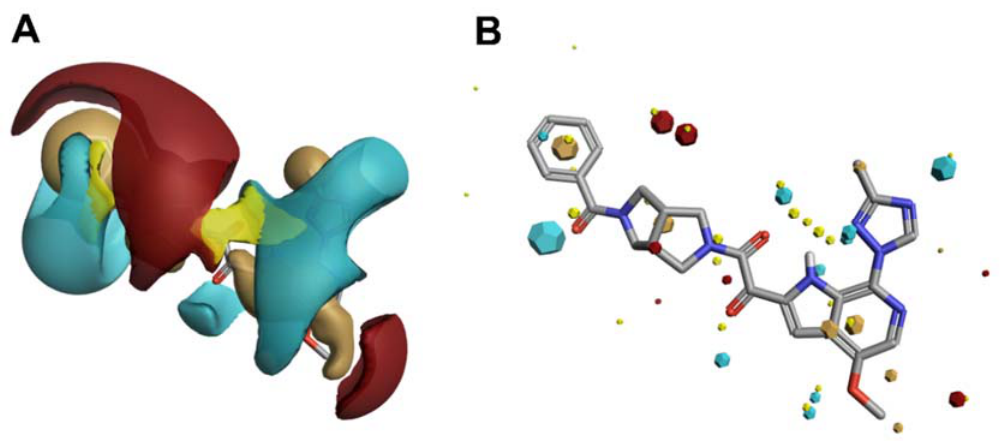
Figure 10. Electrostatic (blue/red), van der Waals (yellow) and hydrophobic (beige) contours ( A ) and Field Point maxima ( B ) of an HIV ‐ 1 entry inhibitor.